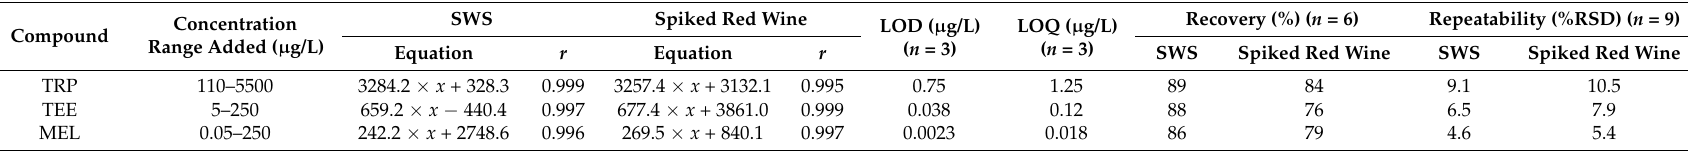
Table 2. Linearity, limits of detection (LOD) and quantification (LOQ), recovery (%), and repeatability (as relative standard deviation, %RSD) for the analytical method developed in HPLC-MS.